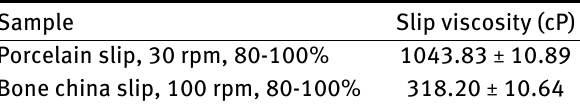
Table 4: Mean viscosity ( ± SD) of clay slip